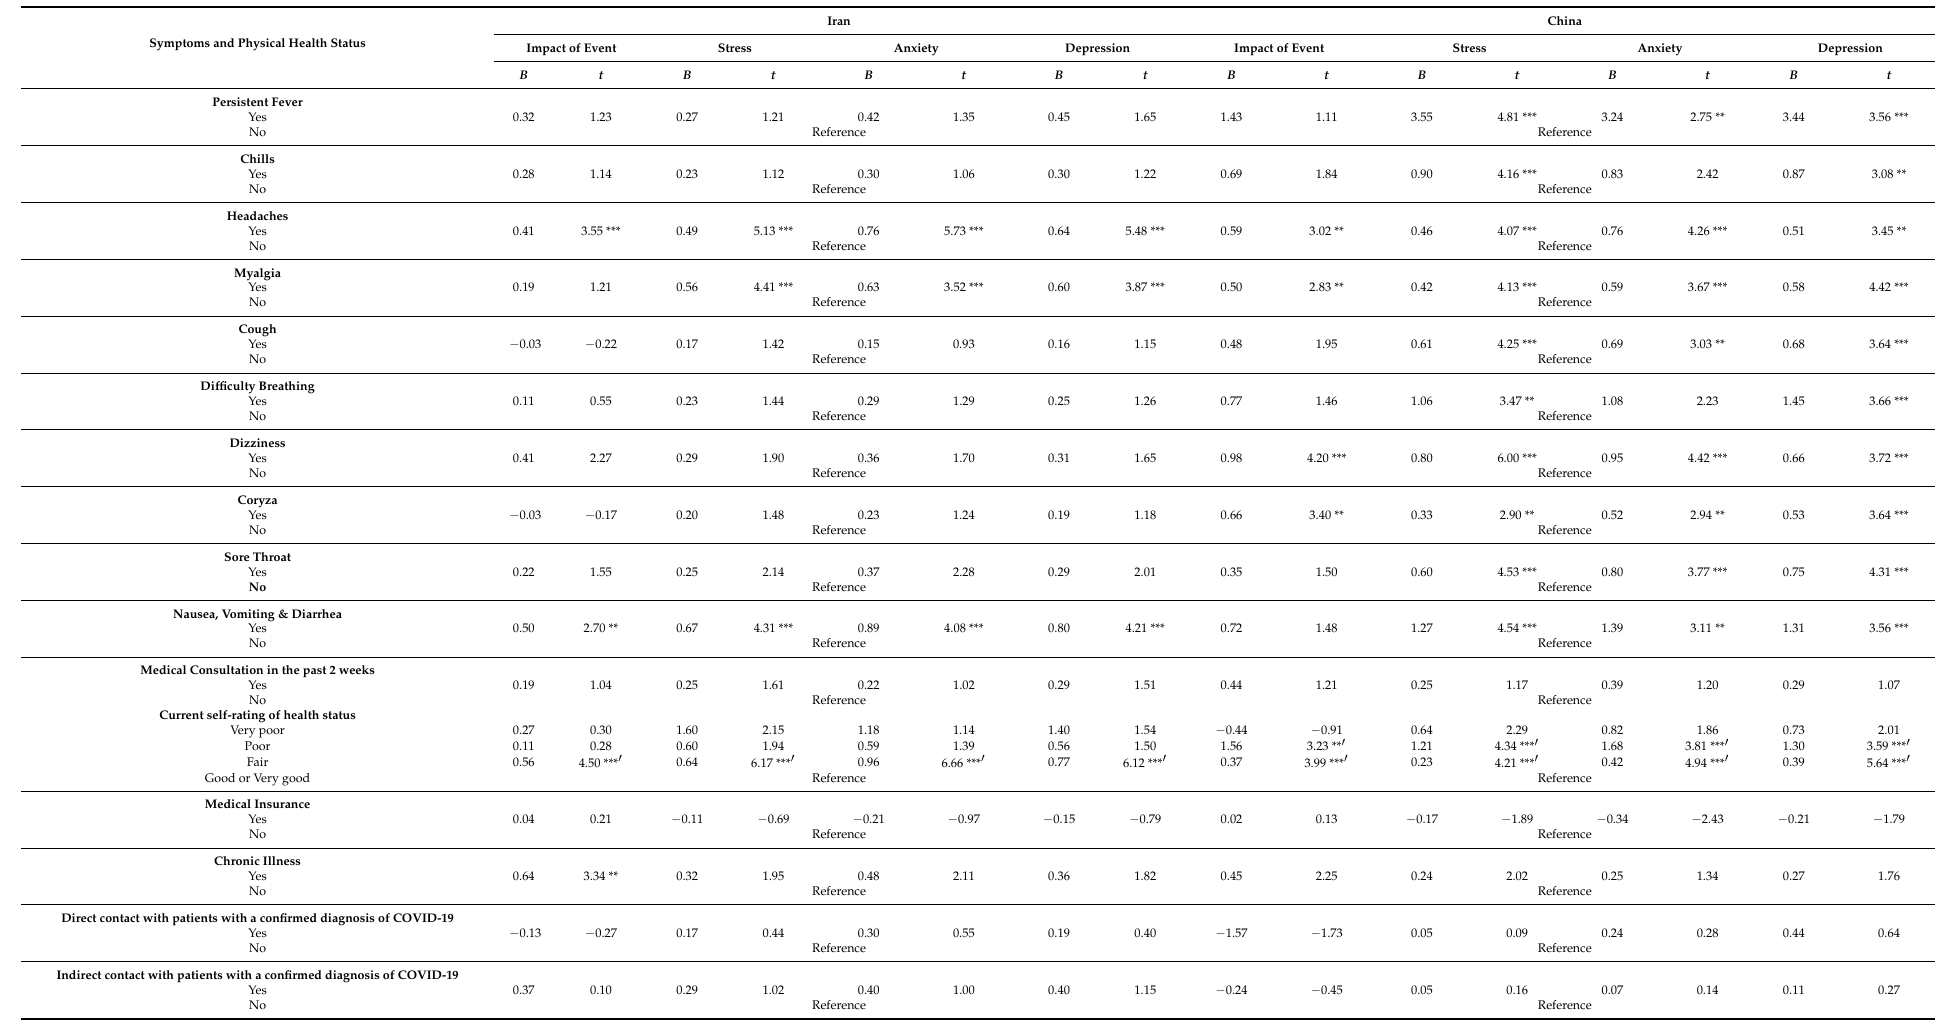
Table 2. The linear regression analysis between physical health and mental health parameters in Iranian and Chinese respondents ( n = 1411). Iran China SymptomsandPhysicalHealthStatus ImpactofEvent Stress Anxiety Depression ImpactofEvent Stress Anxiety Depression